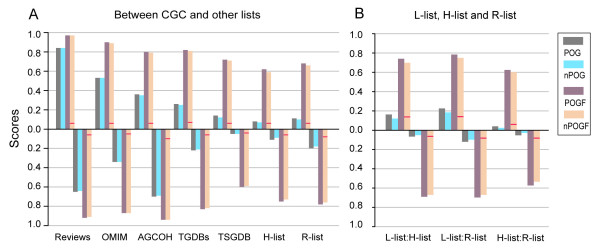
The consistency scores between different cancer gene lists. A. The bars above the x-axis depict POG (nPOG) and POGF (nPOGF) scores from other lists to CGC, and the bars below the x-axis depict the POG (nPOG) and POGF (nPOGF) scores from CGC to other lists. The red lines within the bars depict the POGF scores expected by random chance. B. The POG (nPOG) and POGF (nPOGF) scores between the H-list, L-list and R-List. The bars above the x-axis depict POG (nPOG) and POGF (nPOGF) scores from H-list to L-list, from L-list to R-list and from H-list to R-list respectively. The bars below the x-axis depict scores from L-list to H-list, from R-list to L-list and from R-list to H-list respectively. The red lines within the bars depict the POGF scores expected by random chance.